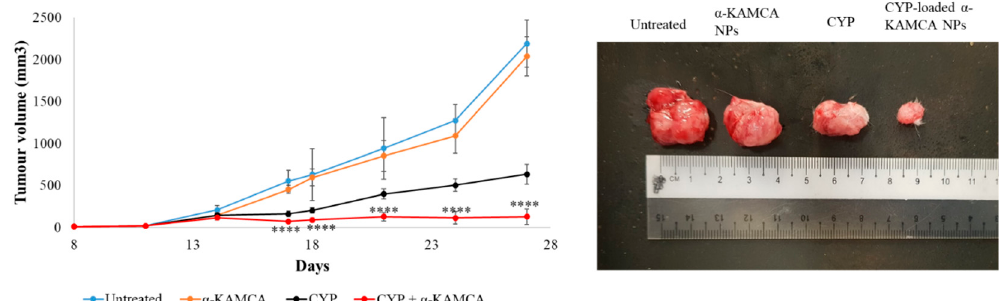
Figure 5. Treatment effects of free CYP, CYP-loaded α -KAMCA NPs, and drug-free α -KAMCA NPs compared to the untreated group of mice. Tumor picture was taken at day 27 after the mice were sacrificed humanely via euthanasia. Values were extremely significant (****) at a p -value < 0.0001 vs. the same treatment with free CYP at a CI of 95%.